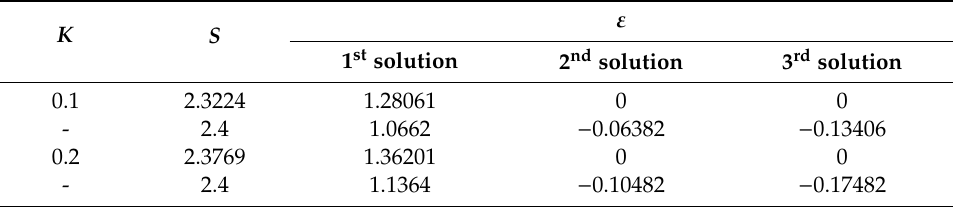
Table 2. Smallest eigen values ε at several values of S and K when Pr =